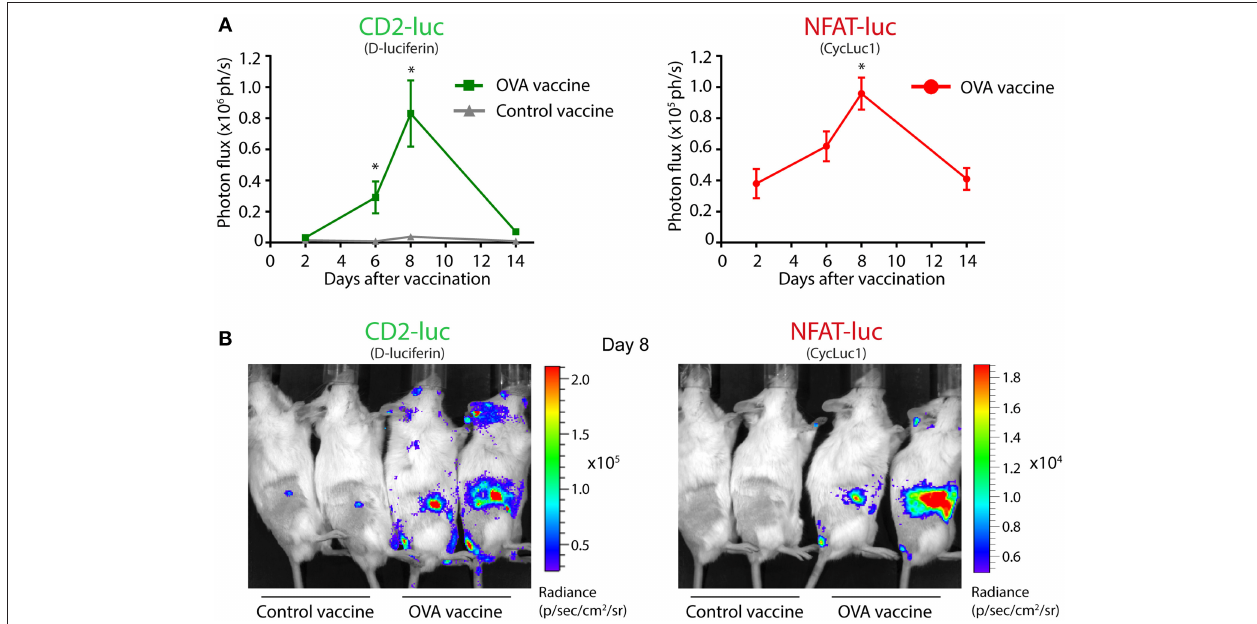
FIGURE 5 | Visualization of T cell localization and activation in vaccinated mice. (A) Constitutive CD2-luciferase (left) and NFAT-luciferase (right) signals from vaccine-draining inguinal lymph nodes of vaccinated mice. On day 0, mice received adoptive transfer of TbiLuc*OT-I CD8 + T cells and were vaccinated with OVA immune complex-preloaded dendritic cells or with unloaded control dendritic cells. Two representative mice are shown per group from a total of 4 mice per group. CD2-CBG99 and NFAT-PpyRE9 luciferases were visualized using the D-luciferin and CycLuc1 substrates, respectively. Mice receiving the control vaccine showed no detectable NFAT-luc signal after subtraction of background. Statistical significance of differences in signal compared to day 2 is indicated by asterisks, * p < 0.05. (B) Representative pictures of OVA-vaccinated and control-vaccinated mice on day 8, showing dramatic T cell proliferation (left) and activation (right) in OVA-vaccinated